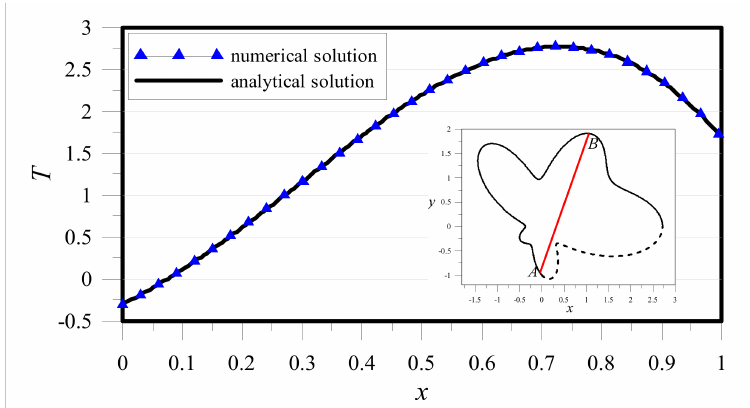
Figure 10. Comparison of the temperature distribution along the selected line